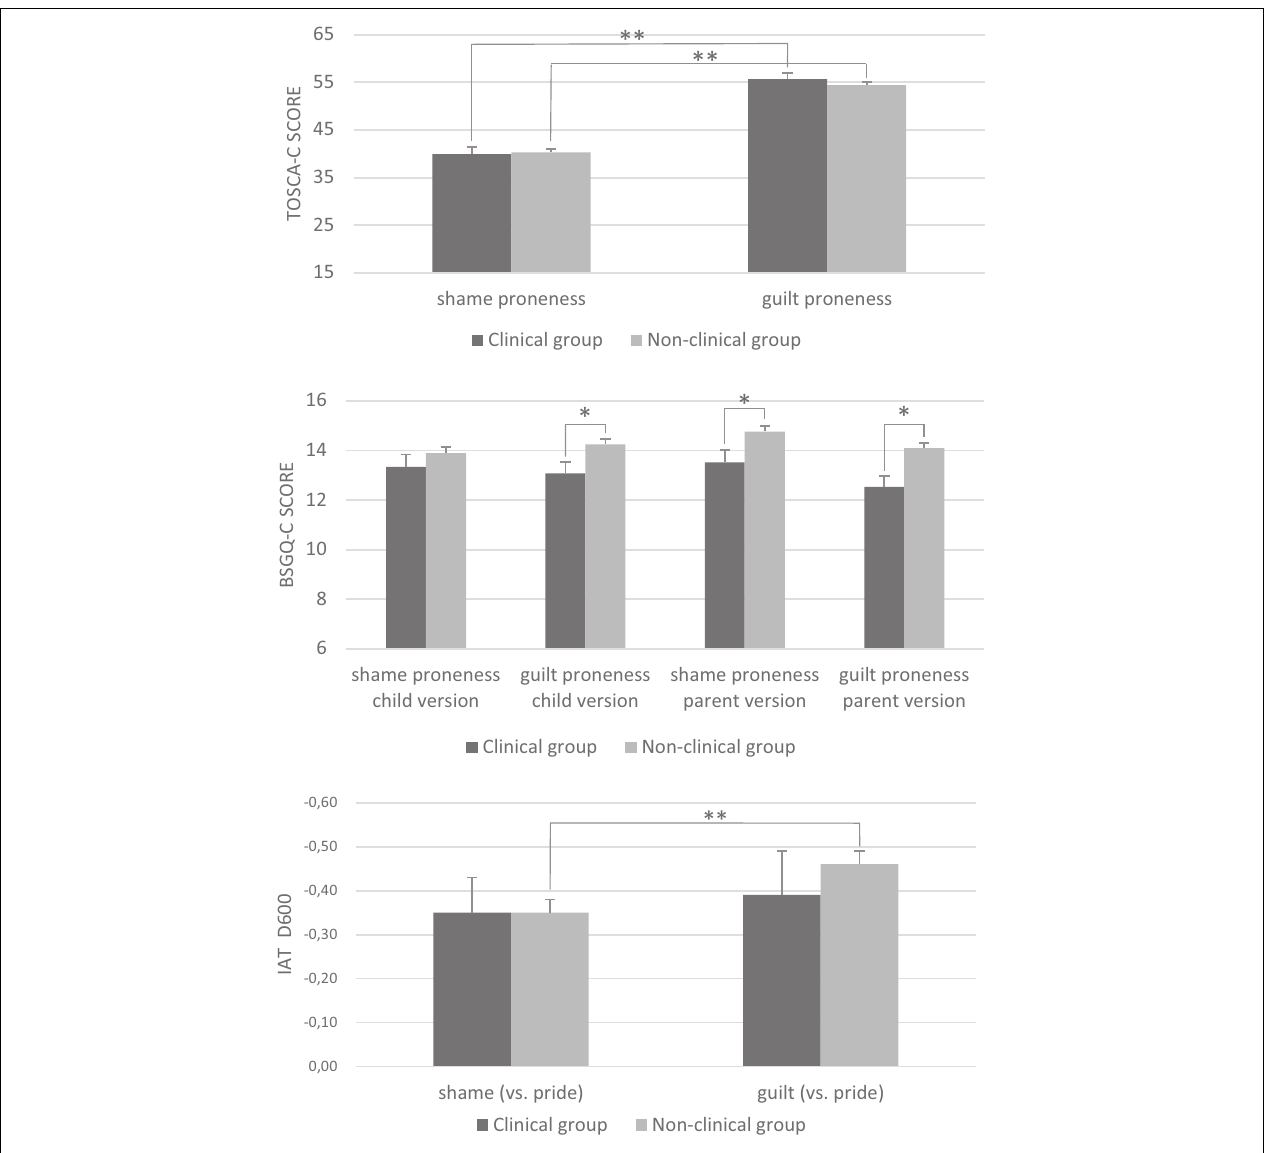
FIGURE 1 | Mean scores (with standard error bars) on various explicit and implicit measures of shame and guilt in the clinical and non-clinical group. BSGQ-C, Brief Shame and Guilt Questionnaire for Children; IAT, Implicit Association Test; TOSCA-C, Test of Self-Conscious Affect for Children. The IAT D600 represents the contrast between the self- conscious emotions and pride. The negative values indicate that in general there was a stronger association with the attribute ‘pride’ than with the self-conscious emotions of ‘shame’ and ‘guilt’. ∗ p < 0.05, ∗∗ p <